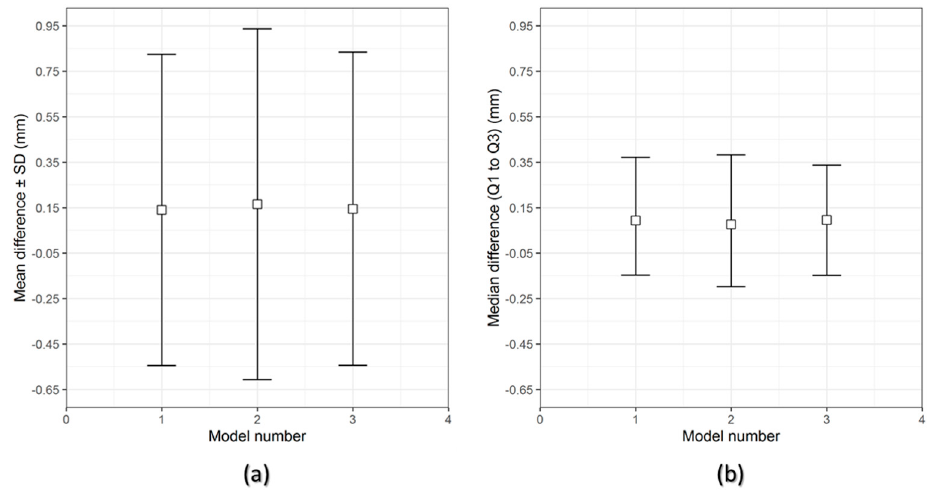
Figure 6. Descriptive data distribution for Group 1 PSIs, illustrating the difference between planned and FFF 3D printed PEEK PSIs (PSI model 1–3). ( a ) mean difference ± SD (mm) and ( b ) median difference (Q1 to Q3) (mm).